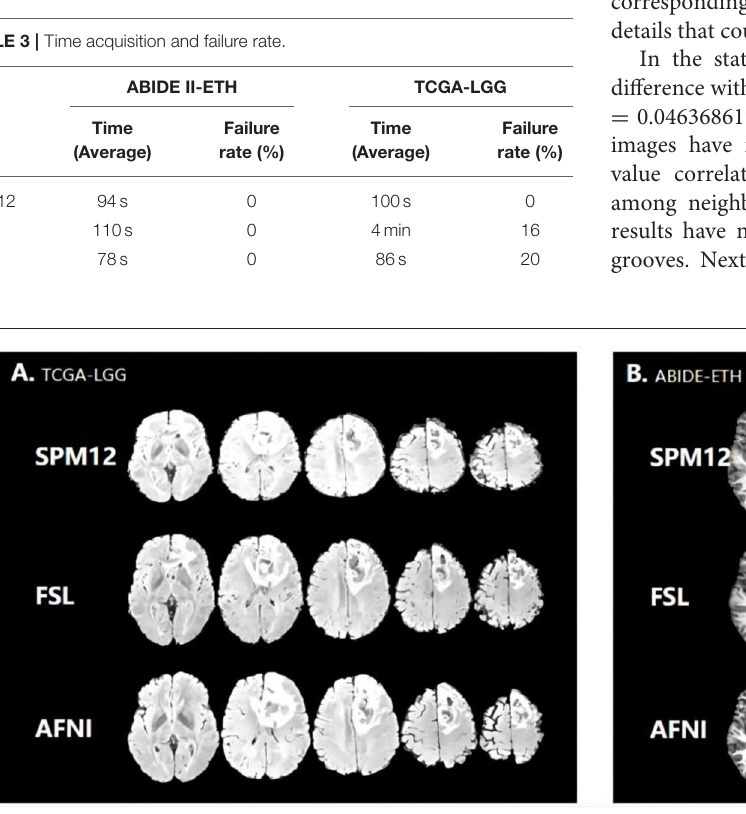
FIGURE 2 | Registered results by three tools. (A) TCGA-LGG. (B) ABIDE-ETH.